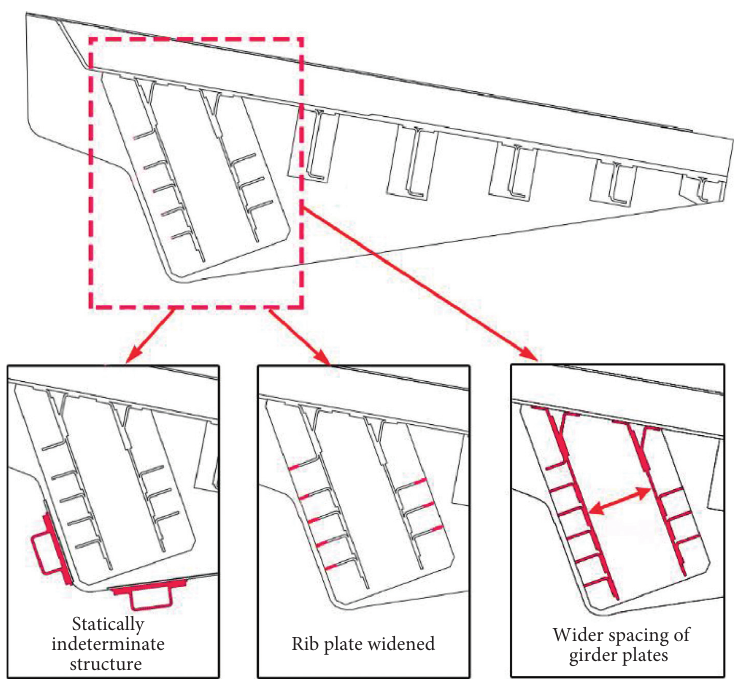
Figure 11: Structural optimization scheme.